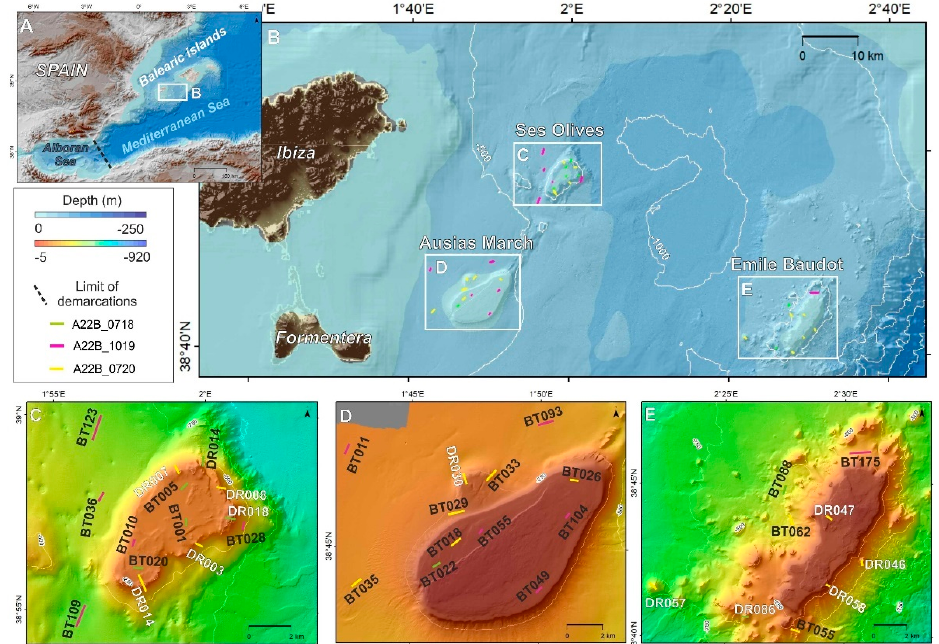
Figure 1. Maps showing: ( A ) western Mediterranean, with the two Mediterranean Spanish demarcations of the MSFD: Straits and Alborán demarcation (ESAL) and Eastern and Balearic demarcation (LEBA), separated with dashed line; ( B ) general view of the total area of study, Mallorca Channel (Balearic Islands); ( C ) Ses Olives; ( D ) Ausias March; and ( E ) Emile Baudot seamounts. Maps C–E show the codes of the sampling stations with new occurrences of molluscans, developed during the INTEMARES surveys. The serial reference is shown above the track: (BT) beam trawl and (DR) rock dredge.